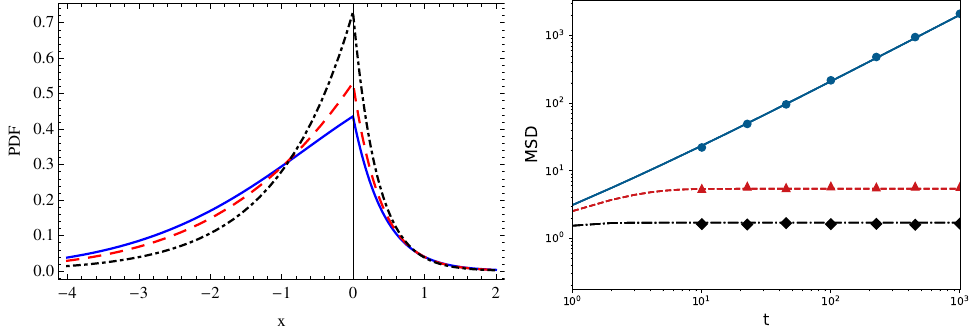
Figure 5. Left panel: PDF (51) at t = 1; right panel: MSD (56) for D x = 1, D y = 1, x 0 = 0, v = − 2, and r = 0 (blue solid line), r = 0.5 (red dashed line), and r = 2 (black dot-dashed line).